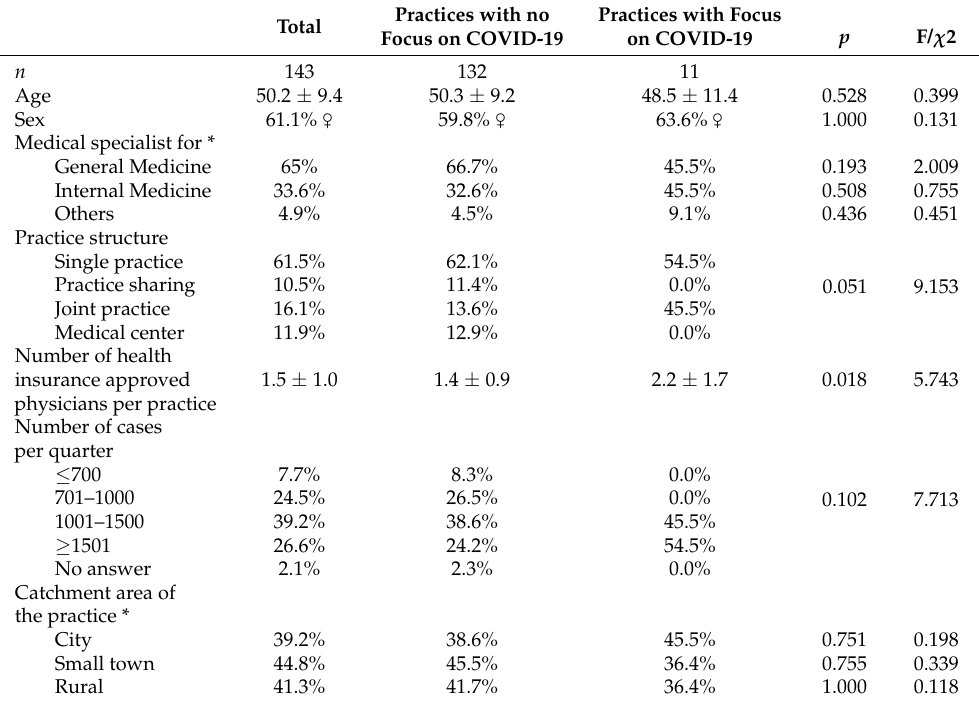
Table 1. Baseline characteristics of participating GPs and their practices.